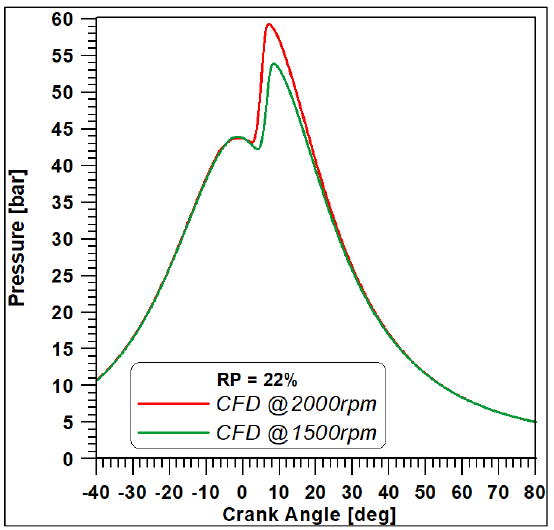
Figure 4. Comparison of in-cylinder pressure curves in RP = 22 @2000 and 1500 rpm cases.